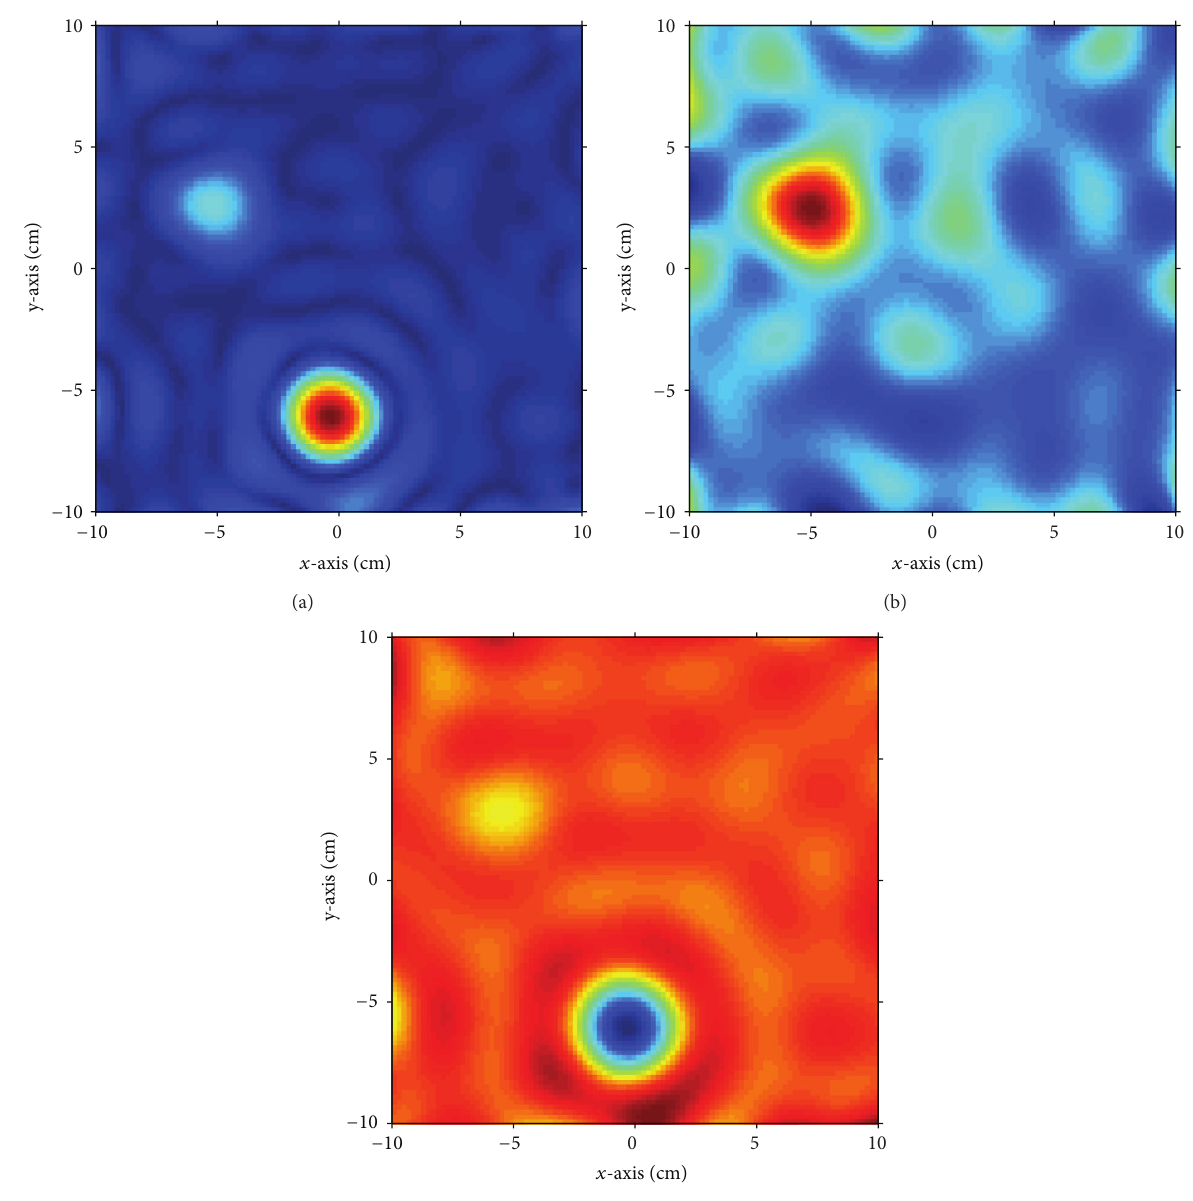
Figure 7: Standard ART method. (a) shows | 𝜀 𝛿 | , (b) shows Re ( 𝜀 𝛿 ) , and (c) shows Im ( 𝜀 𝛿 ) . All images are obtained with 𝜇 = 0.2 and are